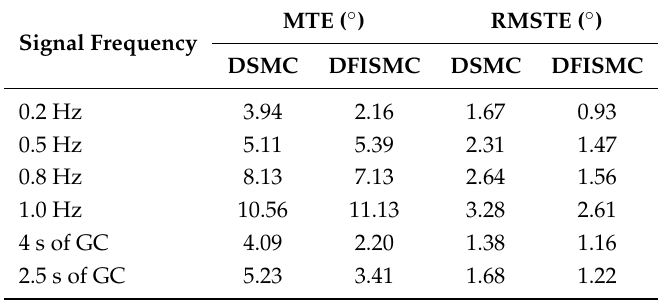
Figure 9. MTE and RMSTE of the proposed controller and conventional DSMC controller with 0.2 Hz, 0.5 Hz, 0.8 Hz, and 1.0 Hz of the desired signal frequency and load m = 2.5 kg. Table 5. MTE and RMSTE of the proposed control method and conventional DSMC control method with load m = 2.5